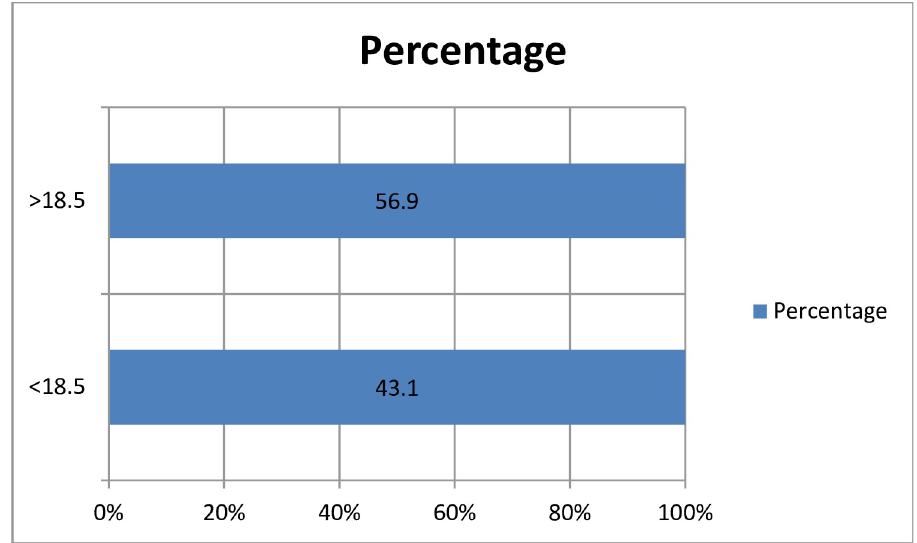
Fig 1. BMI measures of chronic kidney disease patients in Saint Paulo’s and Zewditu Memorial Hospitals in Addis Ababa, Ethiopia, 2018.